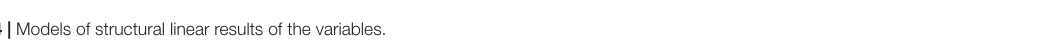
TABLE 4 | Models of structural linear results of the variables.